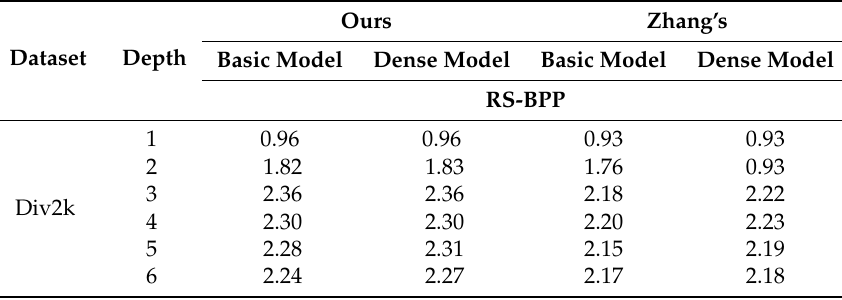
Table 3. The relative payload and model variant compared with